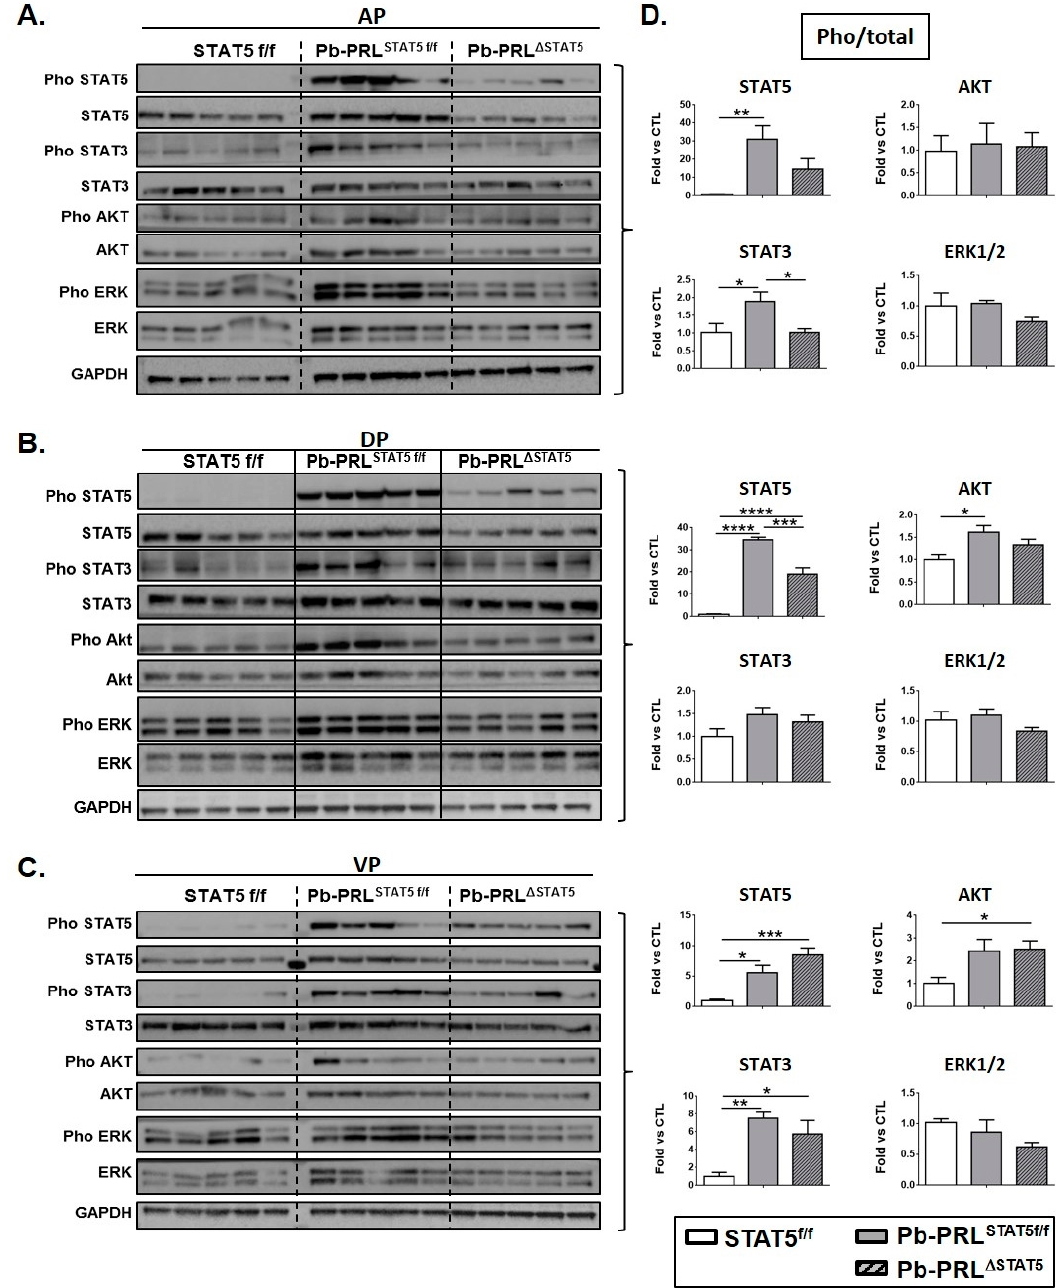
Figure 4. STAT5 deletion does not promote alternative signaling in 6 month-old Pb-PRL ∆ STAT5 mice. ( A – C ). Canonical PRLR signaling pathways were analyzed by immunoblot in anterior ( A ), dorsal ( B ) and ventral ( C ) prostate lobes from STAT5 f / f , Pb-PRL STAT5f / f and Pb-PRL ∆ STAT5 mice (each lane corresponds to a di ff erent mouse). ( D ). The activation of each pathway determined by the ratio of phosphorylated versus total protein (densitometry) is shown as fold-induction versus STAT5 f / f samples. Statistics : Stars denote significant di ff erences in a repeated-measures one-way ANOVA with Tukey’s multiple comparisons.